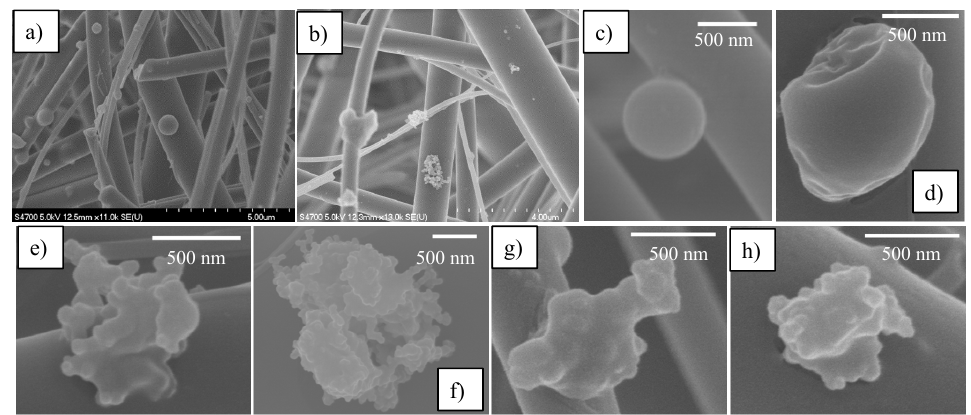
Figure 4. Representative SEM images of particles collected on 9 / 24 (a) and 9 / 25 (b) . Also shown are examples of spherical (43 and 18% in 9 / 24 and 9 / 25, respectively) (c) , near spherical particles (23 and 29% in 9 / 24 and 9/25, respectively) (d) , and embedded soot particles (46 and 17% in 9 / 24 and 9 / 25, respectively) (e–h) .